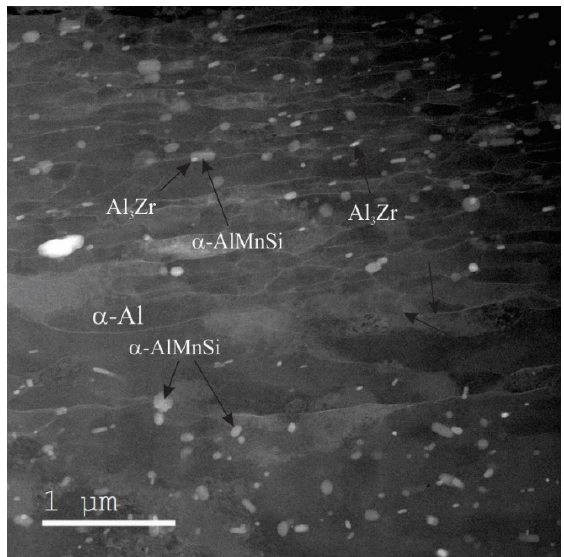
Figure 8. The microstructure after extrusion. The extrusion direction is from left to right. The High-Angle Annular Dark Field (HAADF) image in TEM.